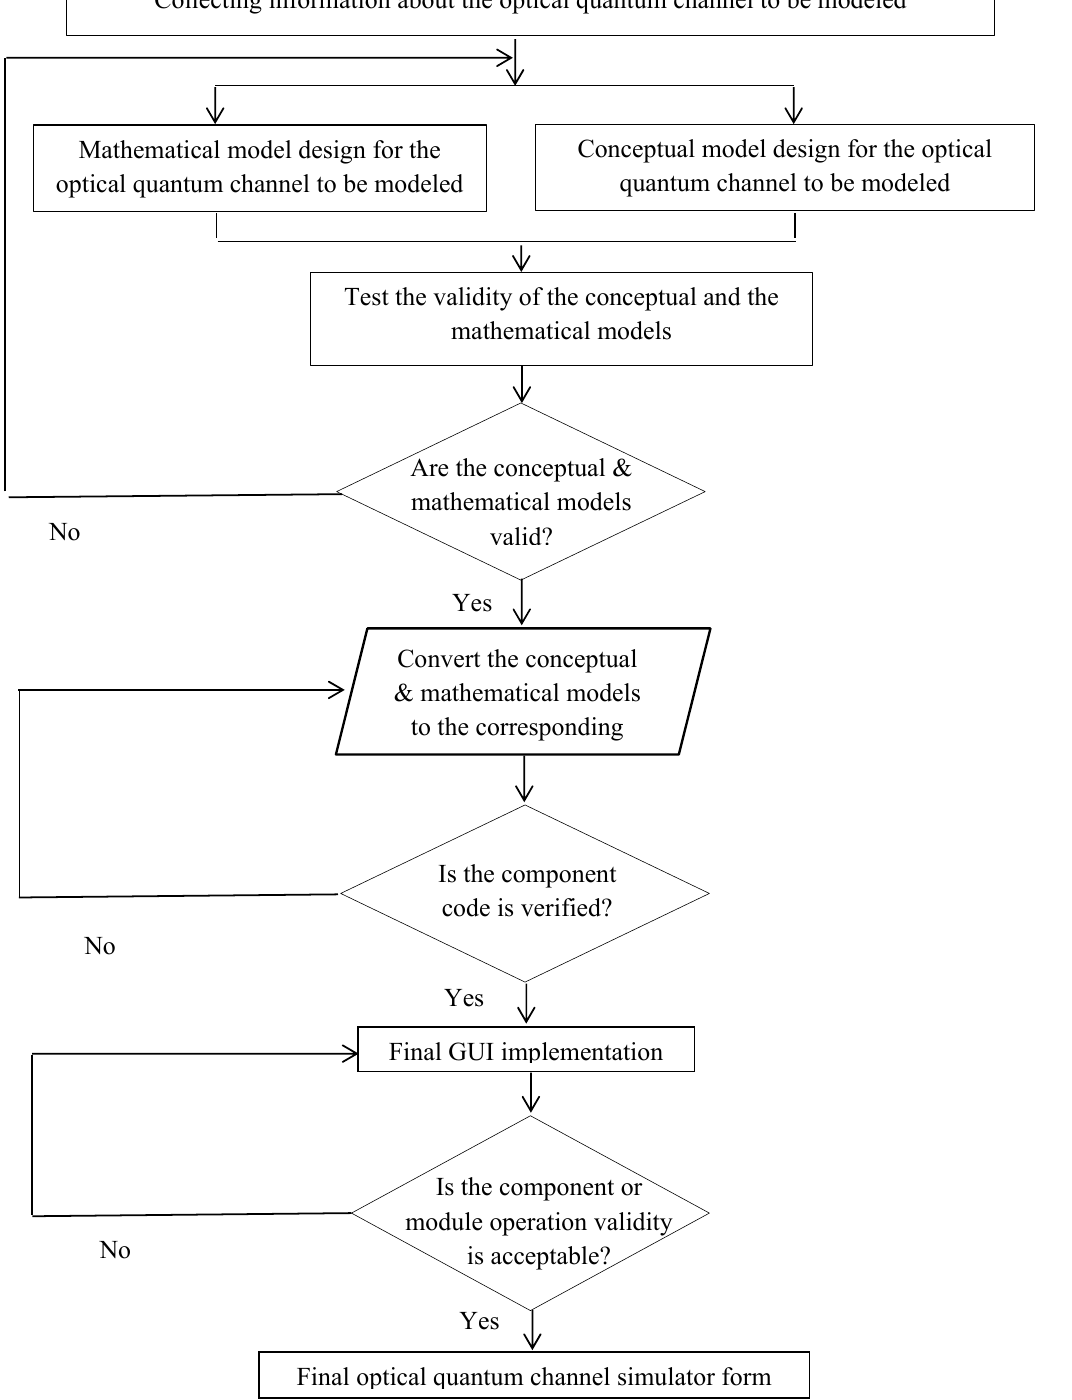
Fig. 4. Modeling process steps. GUI: graphical user